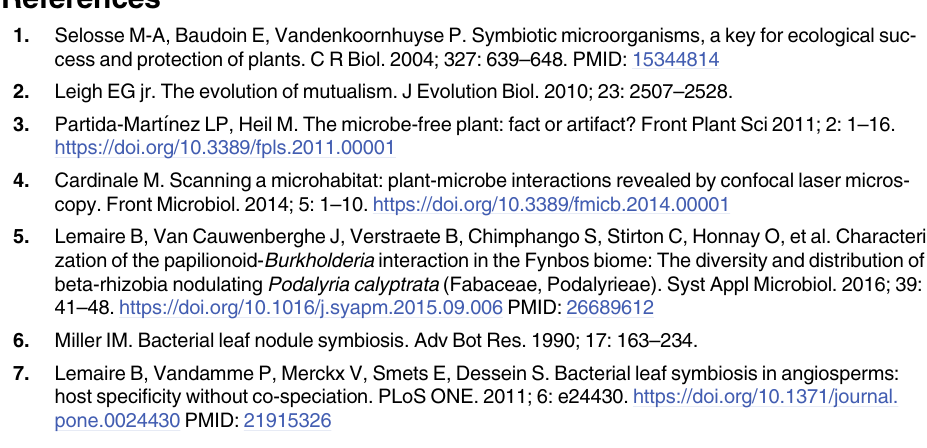
(red, arrow). (B) Same detail as (A), stained with TBO after FISH labelling. (C) Merged epi- fluorescence images of the outer surface of the embryo close to the cotyledons, showing FISH- labelled endophyte (red, arrow). (D) Same detail as (C), stained with TBO after FISH labelling. (E) Merged epifluorescence images of the intercotyledonary space close to the apical shoot meristem, showing FISH-labelled endophyte (red, arrow). (F) Same detail as (E), stained with TBO after FISH labelling. S1 Table. Detailed information on the identification of the endophytes in the different plant structures of Psychotria punctata . List of the detected endophytes, the plant structure from which their DNA was extracted, host plant acquisition numbers of the living collection at the Botanic Garden Meise (BGM), the identity of the endophytes on species level, GenBank accession numbers for 16S rDNA, gyrB and recA , and the BLAST similarity to the identified